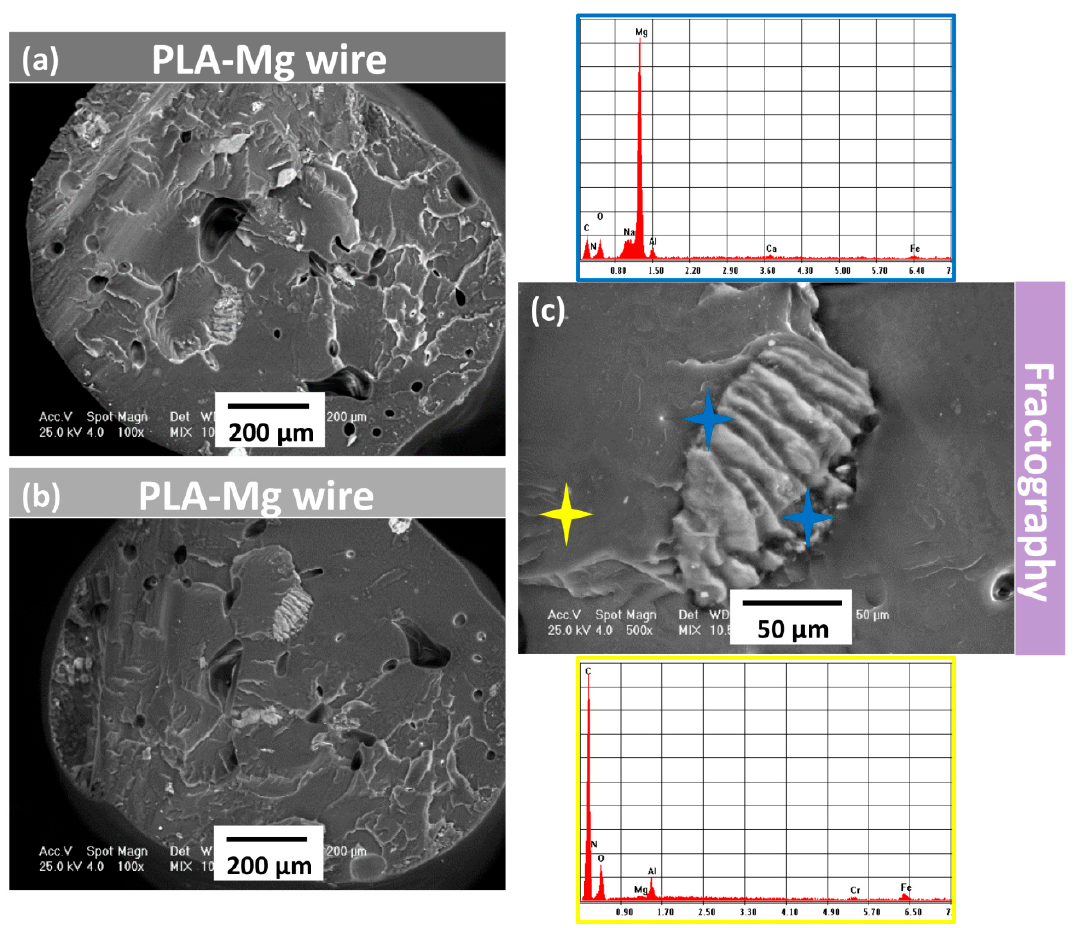
Figure 4. SEM analysis of the experimental wires-fracture section: ( a ) PLA-Mg wire in Composition 2, ( b ) PLA-Mg wire in Composition 1; ( c ) SEM detail in the fracture section coupled with EDS analysis show the presence of Mg particles.